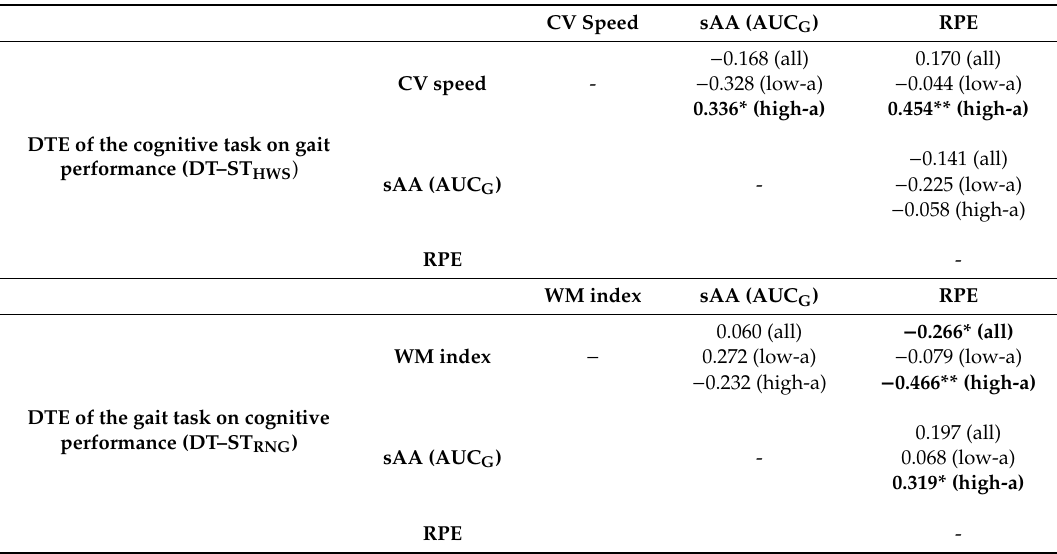
Table 2. Correlations between dual-task e ff ects (DTE) on performance (gait: CV speed; working memory: WM index), autonomic response (AUC G , Pearson’s r) and subjective e ff ort perception (RPE, Spearman’s rho) in all, lower and higher active